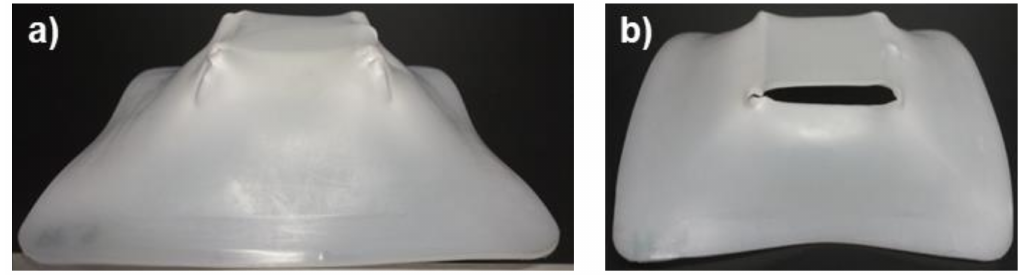
Figure 12. Pyramid-shaped parts made of UHMWPE ( a ) Sheet completely formed; ( b ) Sheet with